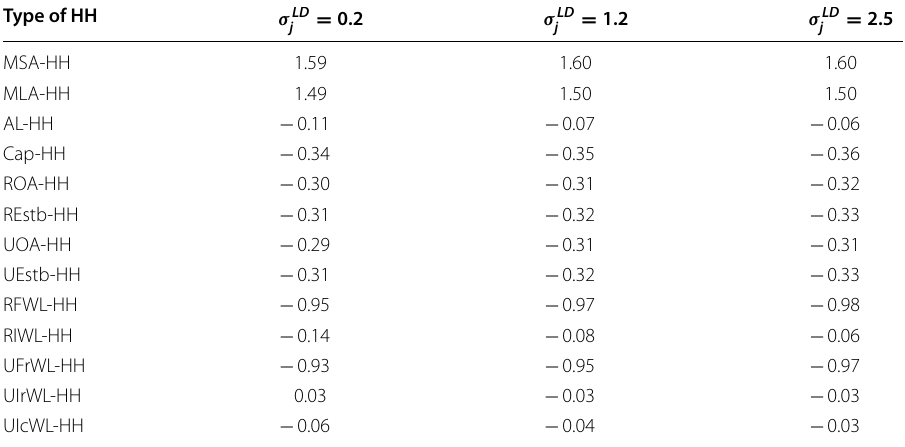
Table 17 Change (%) in household savings due to 50% tariff reduction (segmented labour market-1)